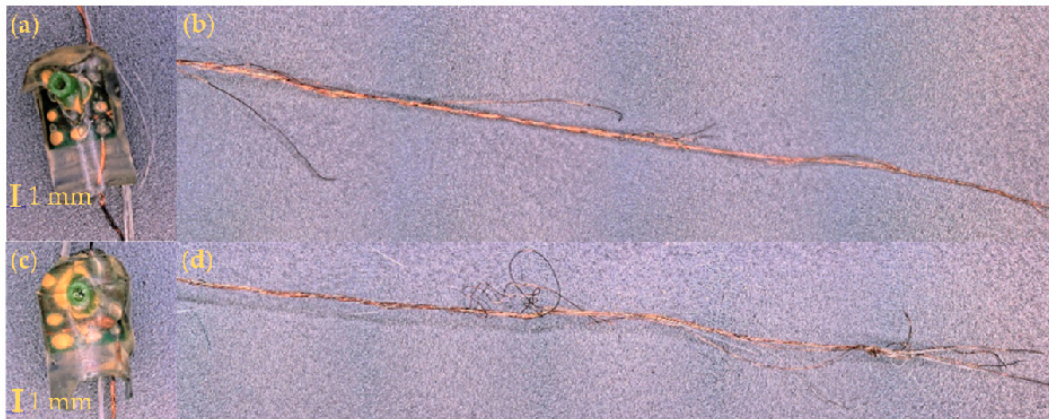
Figure 13. Microscope images of two acoustic sensing E-yarns that were washed within a woven structure and tumble dried. The images to the right show a section of the copper wire used to output signal: ( a ) Yarn A encapsulated microphone; ( b ) the copper wire interconnect from Yarn A; ( c ) Yarn B encapsulated microphone; ( d ) the copper wire interconnect from Yarn B.